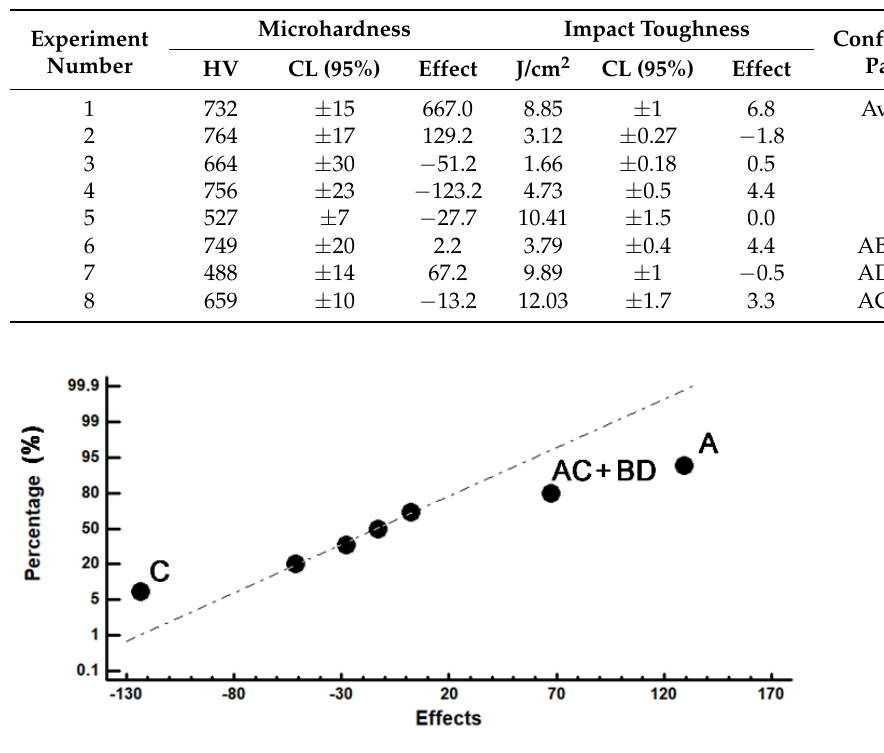
Figure 7. Representation of the factors with significant effect on the hardness of the matrix constituent on a normal probability graph. A (destabilisation temperature); B (cooling media); C (tempering temperature); D (tempering